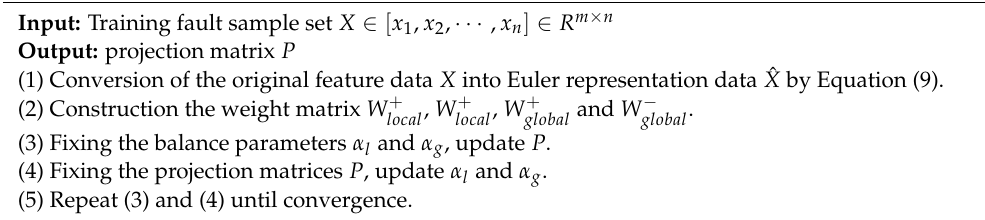
Algorithm 1 Euler Representation Based Structural Balance Discriminant